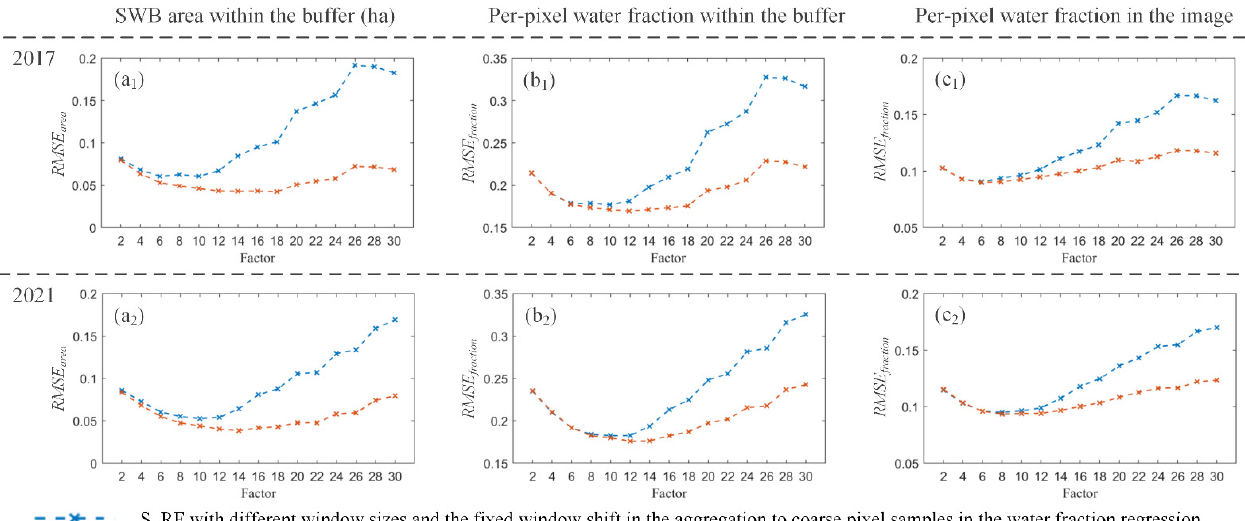
Figure 10. Accuracies in self-trained random forest regression (S_RF) and automated and hierarchical surface water fraction mapping (AHSWFM) with different window sizes and the fixed window shift in the aggregation to coarse pixel samples in the water fraction regression. ( a 1 , a 2 ) RMSE area values in the estimation of small water body (SWB) area, ( b 1 , b 2 ) RMSE fraction values in the estimation of SWB fractions in the buffer and ( c 1 , c 2 ) RMSE fraction values in the estimation of SWB fractions in the entire image.